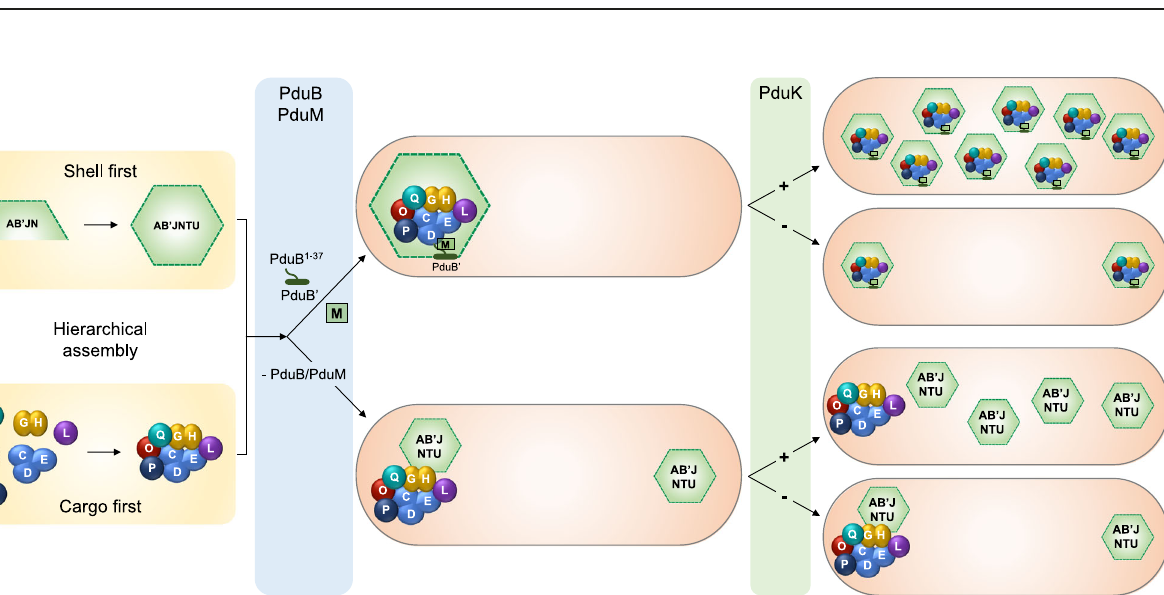
Fig. 6 Interactions and liquid-like association of internal enzymes. a Relevant genes encoding catalytic proteins of relevance to b – e , highlighted in the context of the pdu operon of S . Typhimurium LT2. b , c PduE-sfGFP (green) and mCherry (red, labeling different internal enzymes) were visualized in Δ pduCDE ( b ) and Δ pduB 1 – 37 / Δ pduCDE ( c ) grown in MIM + 1,2-PD media. d , e PduE-sfGFP (green) and mCherry (red, labeling different internal enzymes) were visualized in Δ pduOPQS ( d ) and Δ pduB 1 – 37 / Δ pduOPQS ( e ) grown in MIM + 1,2-PD media. f Representative fl uorescence images before bleaching, immediately after bleaching of PduE-sfGFP (cargo) and PduA-sfGFP (shell), at various time lapses. The yellow rectangular boxes indicated the bleaching area. g Representative time course of fl uorescence recovery of bleached regions of PduE-sfGFP (red) and PduA-sfGFP (cyan). The y-axis indicates fl uorescence values relative to the fl uorescence intensity of the selected region prior to bleaching. The recovery of sfGFP fl uorescence is shown as circles and fi tted to an exponential function.